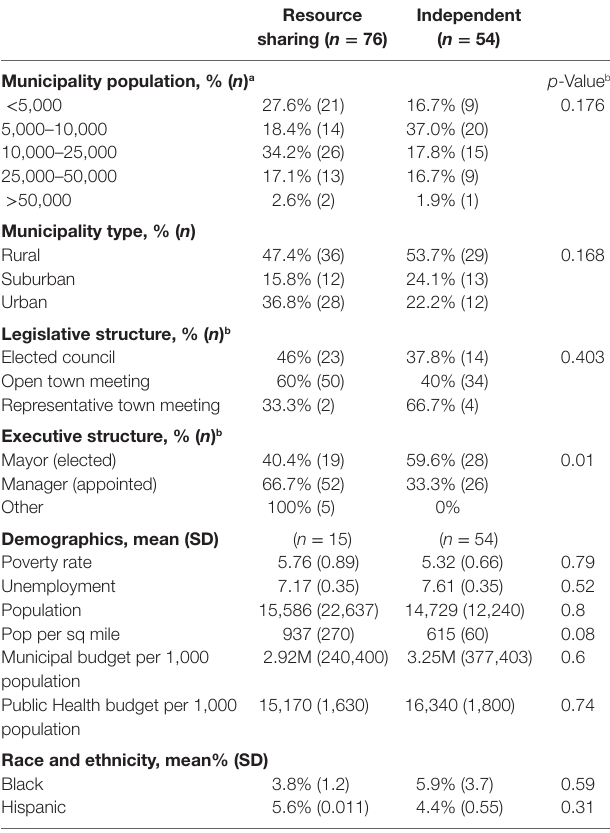
TaBle 1 | Characteristics of independent and sharing